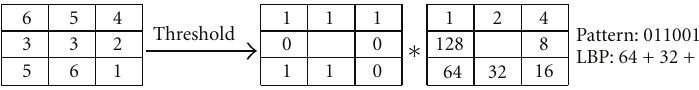
Figure 1: Illustration of LBP operator.